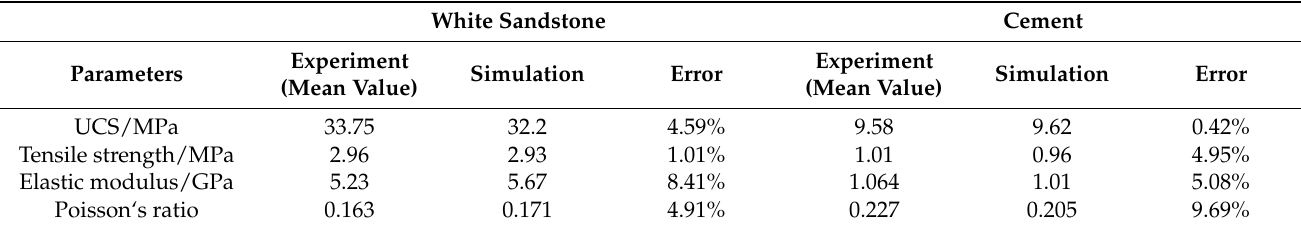
Table 4. Parameter value comparison between experiment and